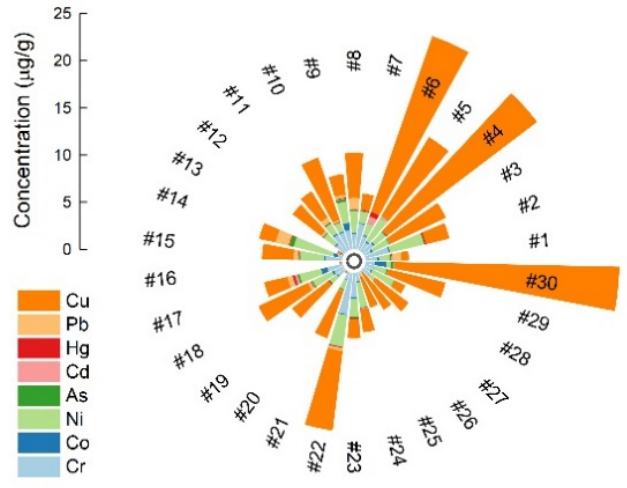
Figure 1. The eight elements metal content of thirtieth spices from Romanian market.